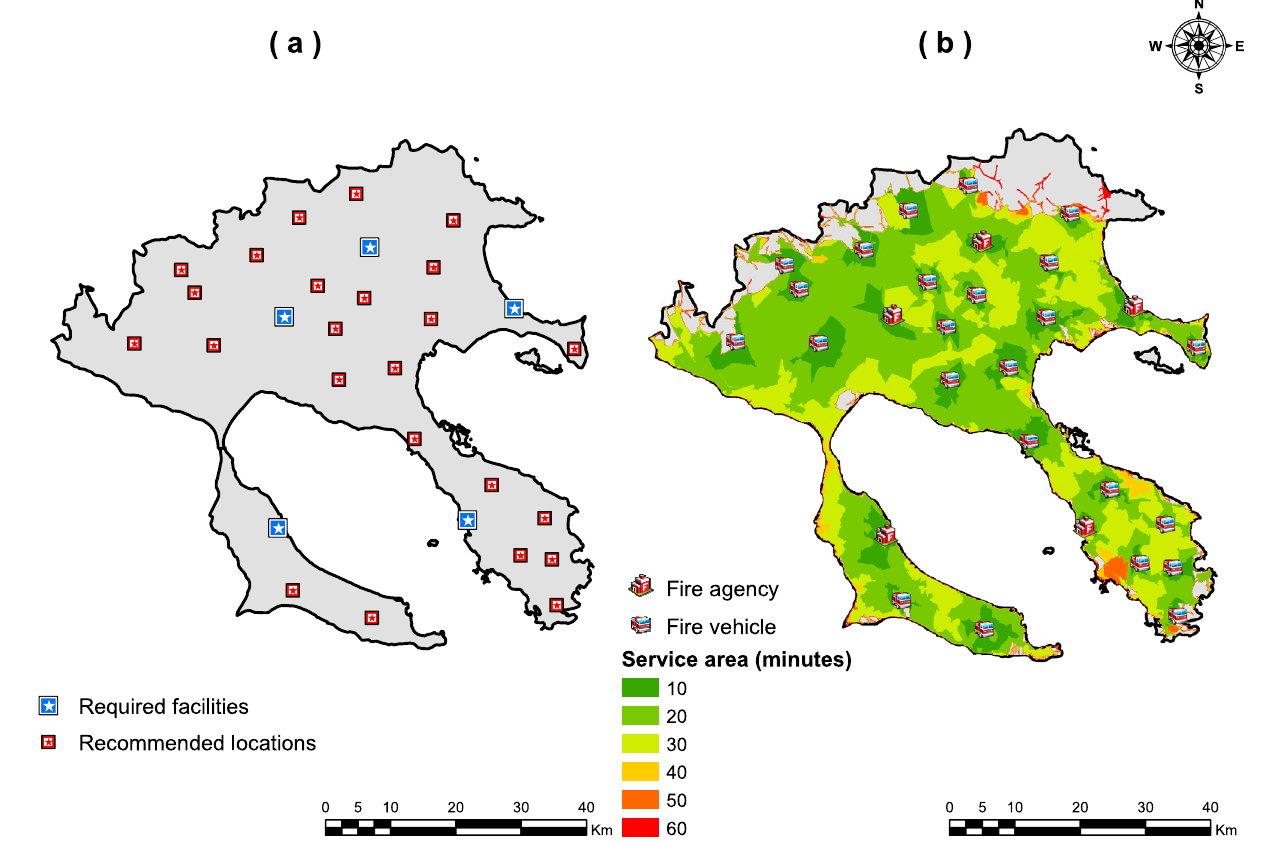
Fig. 7 Estimation of locations of the available forces for initial attack (considering the topography effect on travel time and speed) maxi- mizing the coverage of the most susceptible regions. a Spatial deter-